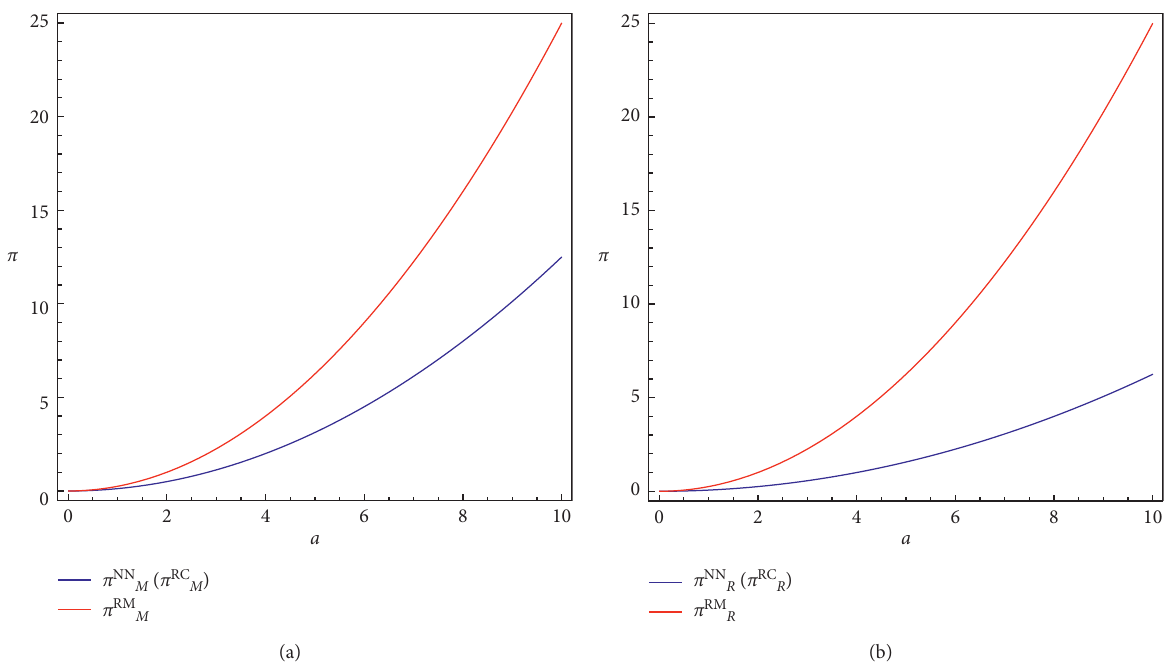
Figure 1: Manufacturer’s and retailer’s profits in the monopoly supply chain system versus a ( m � 1/2 ) . (a) Manufacturer’s profits. (b) Retailer’s profits. Table 2: Equilibrium results in the duopoly supply chain system.